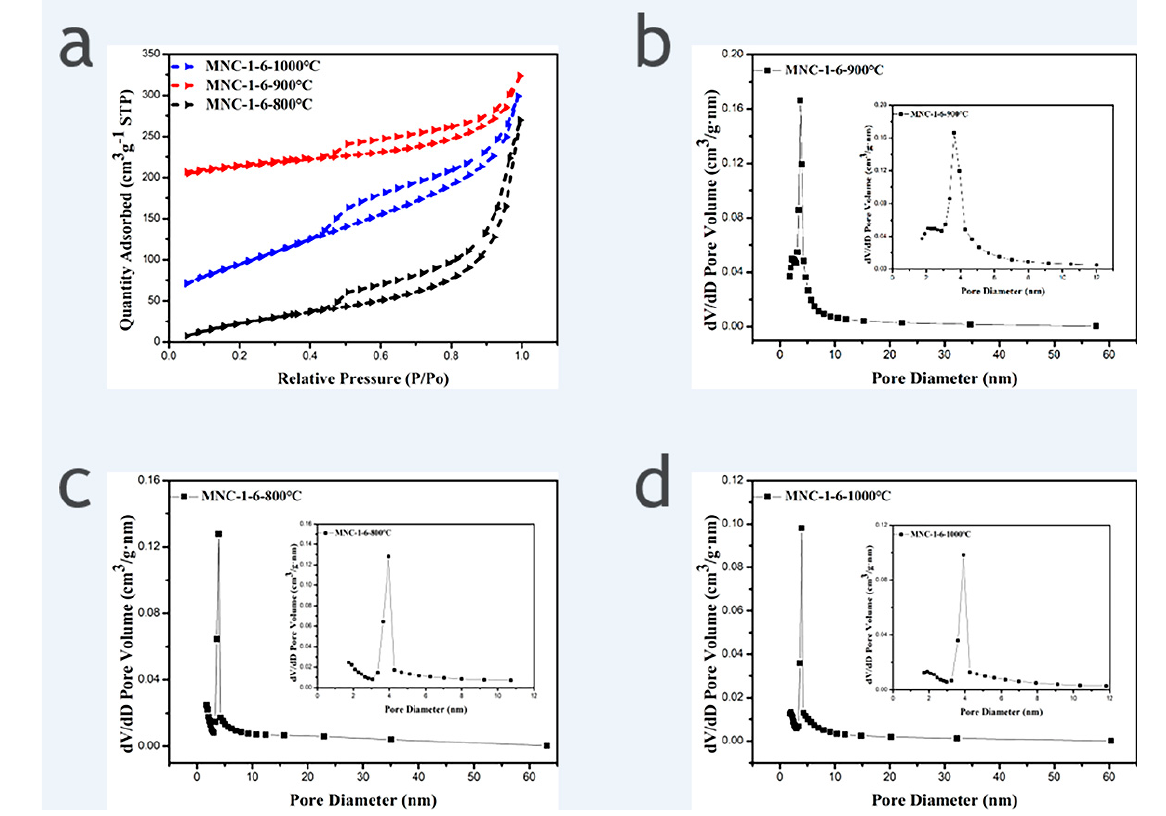
Figure 3. ( a ) N 2 adsorption and desorption isotherms of MNC-1-6-800 °C, MNC-1-6-900 °C and MNC-1-6-1000 °C; ( b – d ) the corresponding pore size distribution curve (Inset: Enlarged view of the corresponding small size pore size distribution).